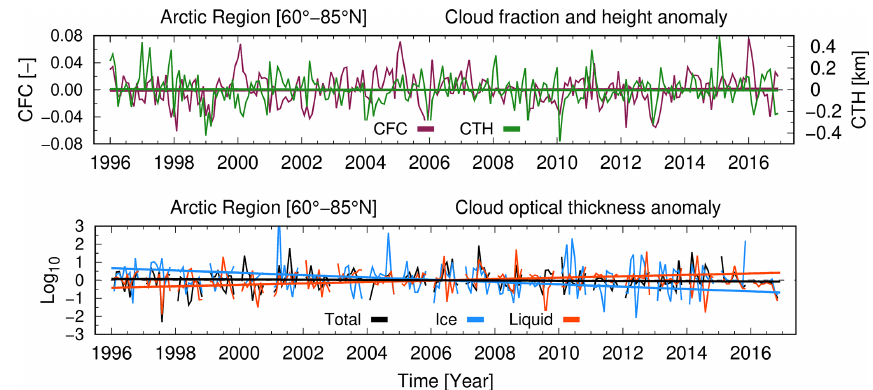
Figure 8. Pan-Arctic anomalies and linear trends of cloud fractional cover (CFC), top height (CTH), and optical thickness (COT, τ ) of all, liquid, and ice clouds.